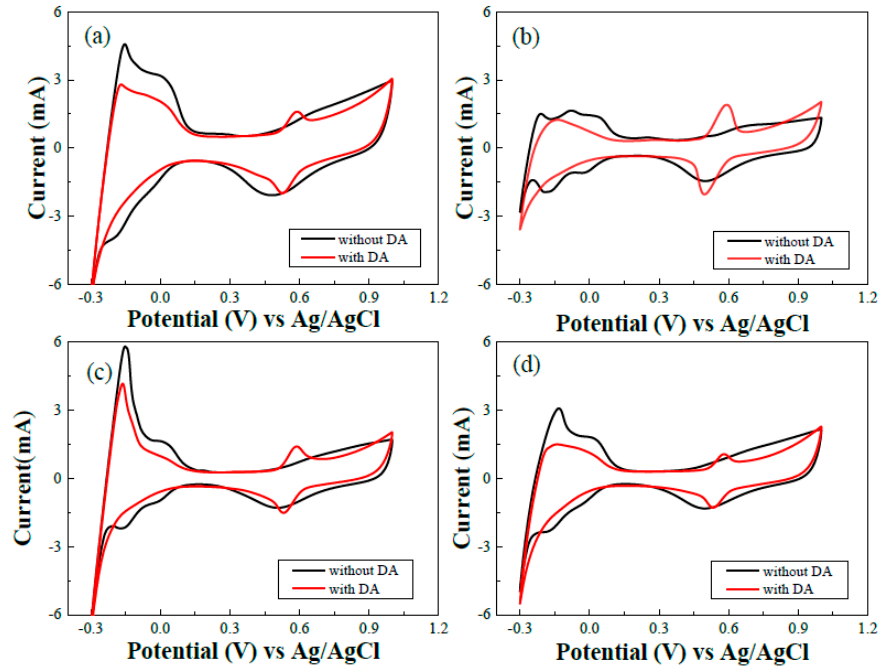
Figure 4. Cyclic voltammograms in the presence and absence of 10 mM DA for ( a ) Pt/C; ( b ) Pt-Mo/C; ( c ) Pt-Zr/C; and ( d ) Pt-Fe-Ir/C electrocatalysts: scan rate = 0.1 V/s, in 0.5 M HClO 4 solution.